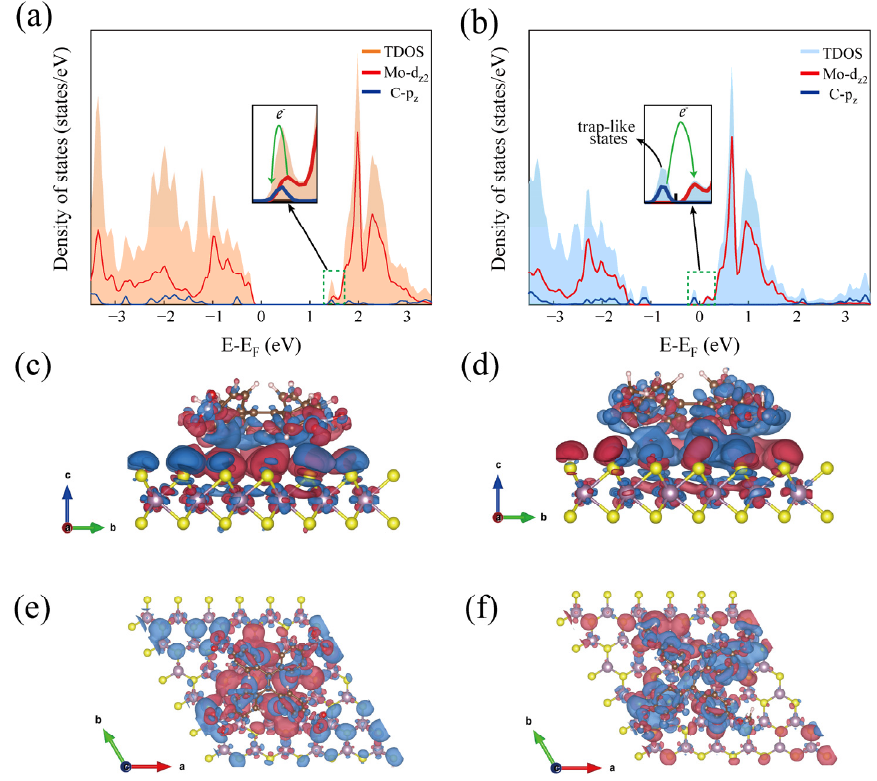
Figure 4. TDOS and PDOS of TPE-4NO 2 doped ( a ) and TPE-4OCH 3 doped ( b ). Front ( c ) and top views ( e ) of the charge density difference of MoS 2 /TPE-4NO 2 . Front ( d ) and top views ( f ) of the charge density difference of MoS 2 /TPE-4OCH 3 . Red and blue isosurfaces represent the charge accumulation (i.e., a gain of electron density) and depletion (i.e., a loss of electron density) in the system, respectively.